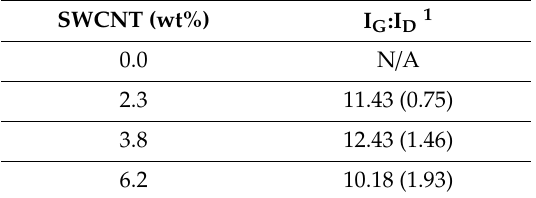
Table 5. The I G :I D ratio determined from the Raman spectrum (514 nm) of Cu–SWCNT composites electrodeposited at a bath temperature of 60 ◦